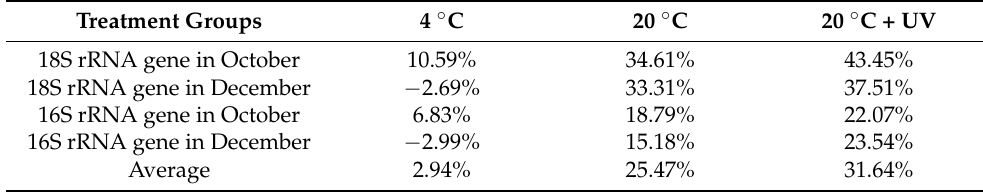
Table 1. The decay rate in the exponential decay models in the different treatment groups.